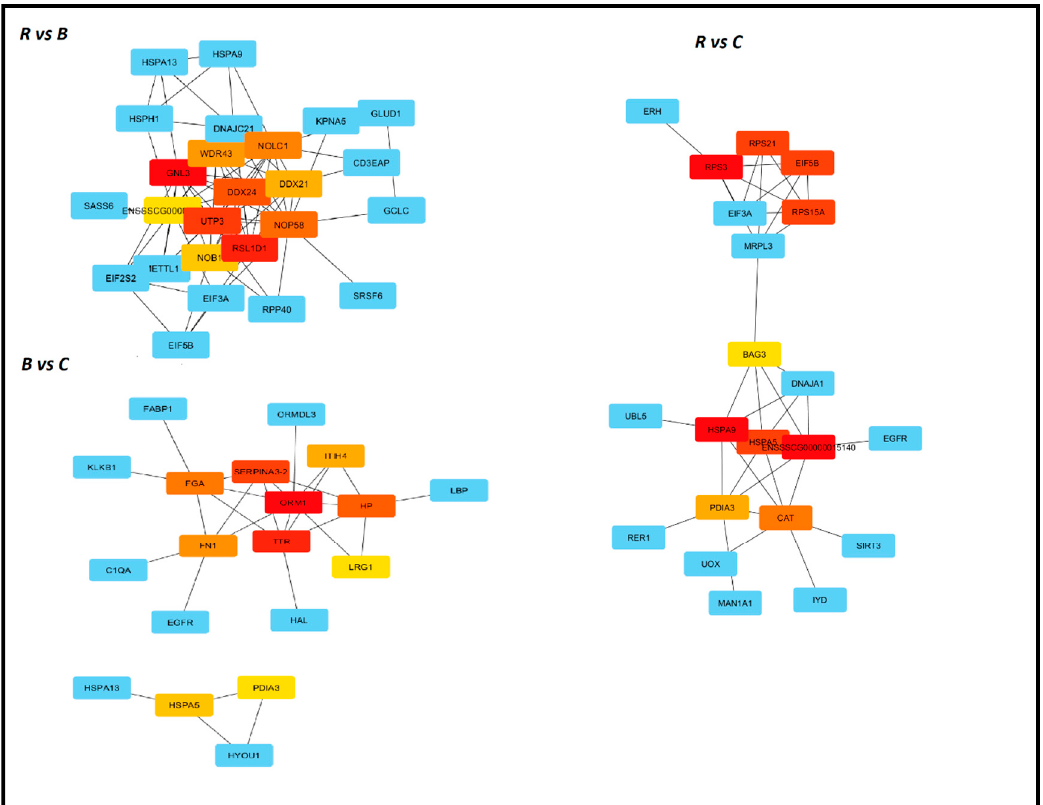
Figure 6. Top 10 Hub genes identified in the R vs. B comparison, R vs. C comparison, and B vs. C comparison using Cytohubba, ranked by MCC (Maximal Clique Centrality). The more intense the red color, the higher the position in the rank.